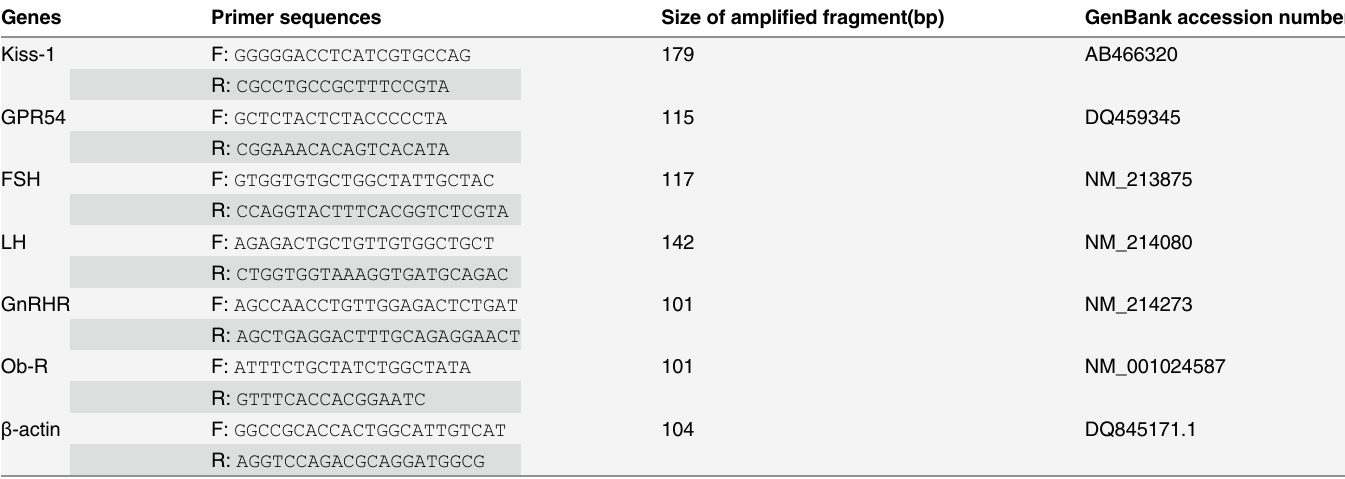
GPR54: G protein-coupled receptor 54, FSH: follicle stimulating hormone, LH: luteinizing hormone, GnRHR: gonadotropin-releasing hormone receptor, Ob-R: leptin